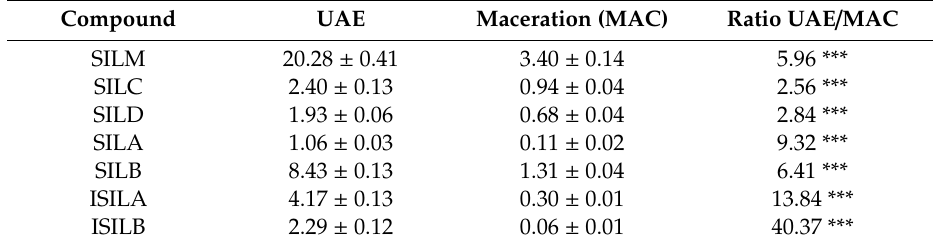
Table 7. Comparison between conventional the present optimized ultrasound-assisted extraction (UAE) vs conventional heat reflux method